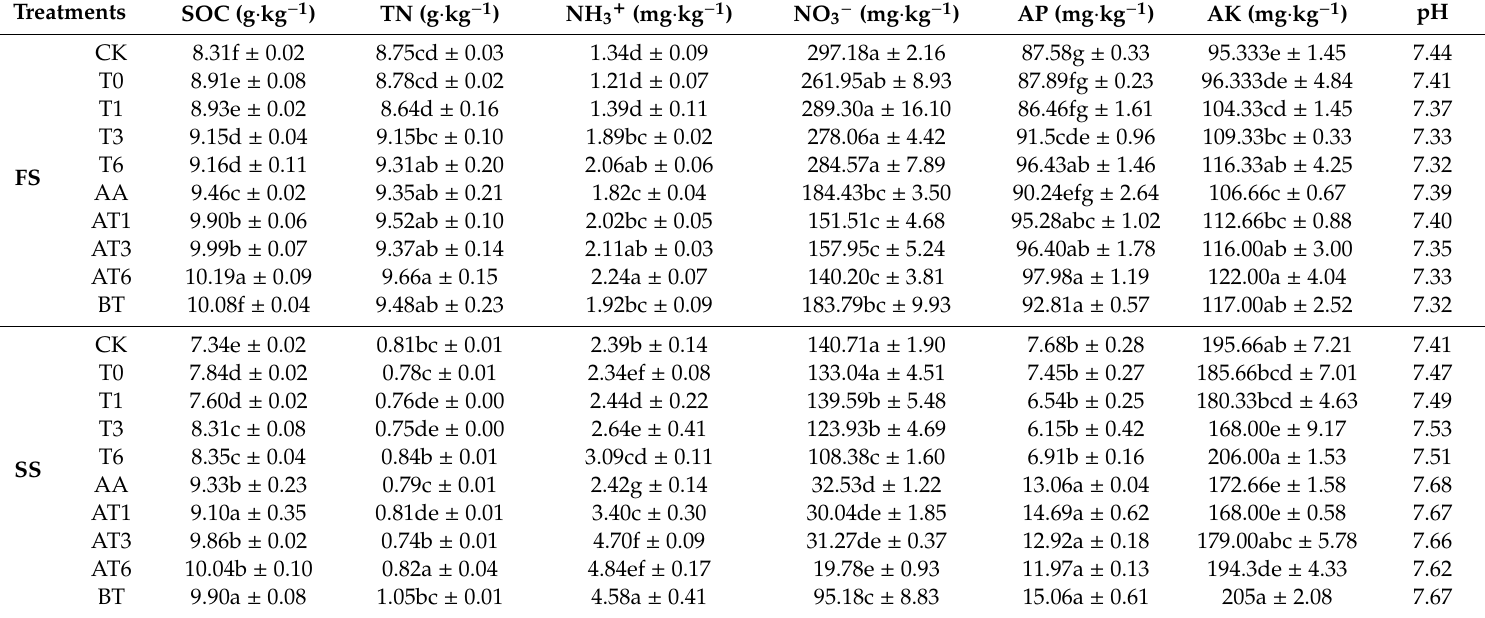
Table 3. The physiochemical characterization of sandy soil during two seasons after the harvest.